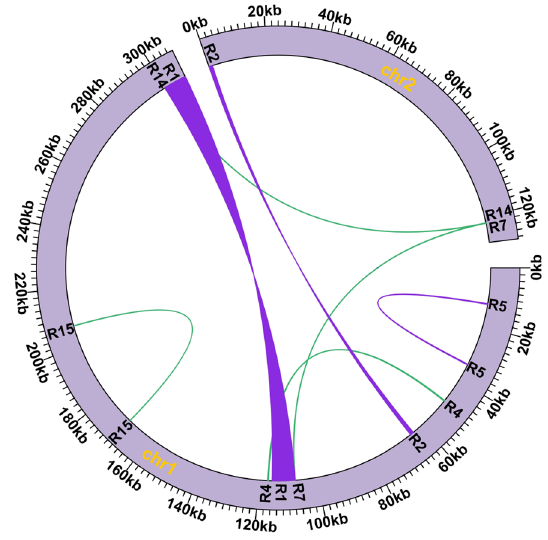
Figure 2. The location of seven repeated sequences in the C. speciosa mitochondrial genome. The green and purple lines inside the circle represent seven repeated sequences, and the pairs of R2, R7, and R14 were found on two different chromosomes, while the rest of the repeat pairs were found on chromosome 1. Table 3. The recombination frequency of seven repeat pairs in the C. speciosa mitochondrial genome.